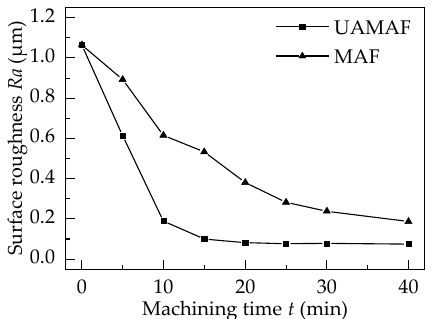
Figure 11. Variation curve of surface roughness with machining time.